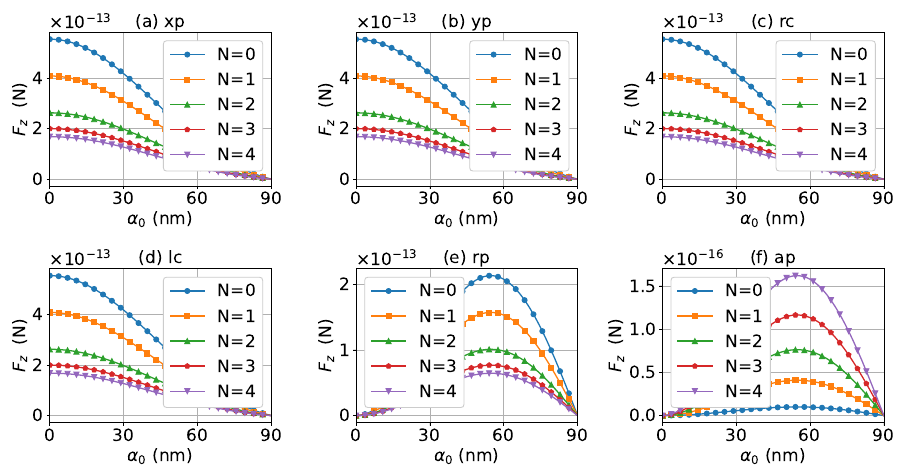
Figure 18. The axial optical force F z exerted on a graphene-coated gold nanosphere by a zeroth-order vector Bessel beam as a function of half-cone angle α 0 with various layer numbers N . The wavelength is λ = 480 nm.